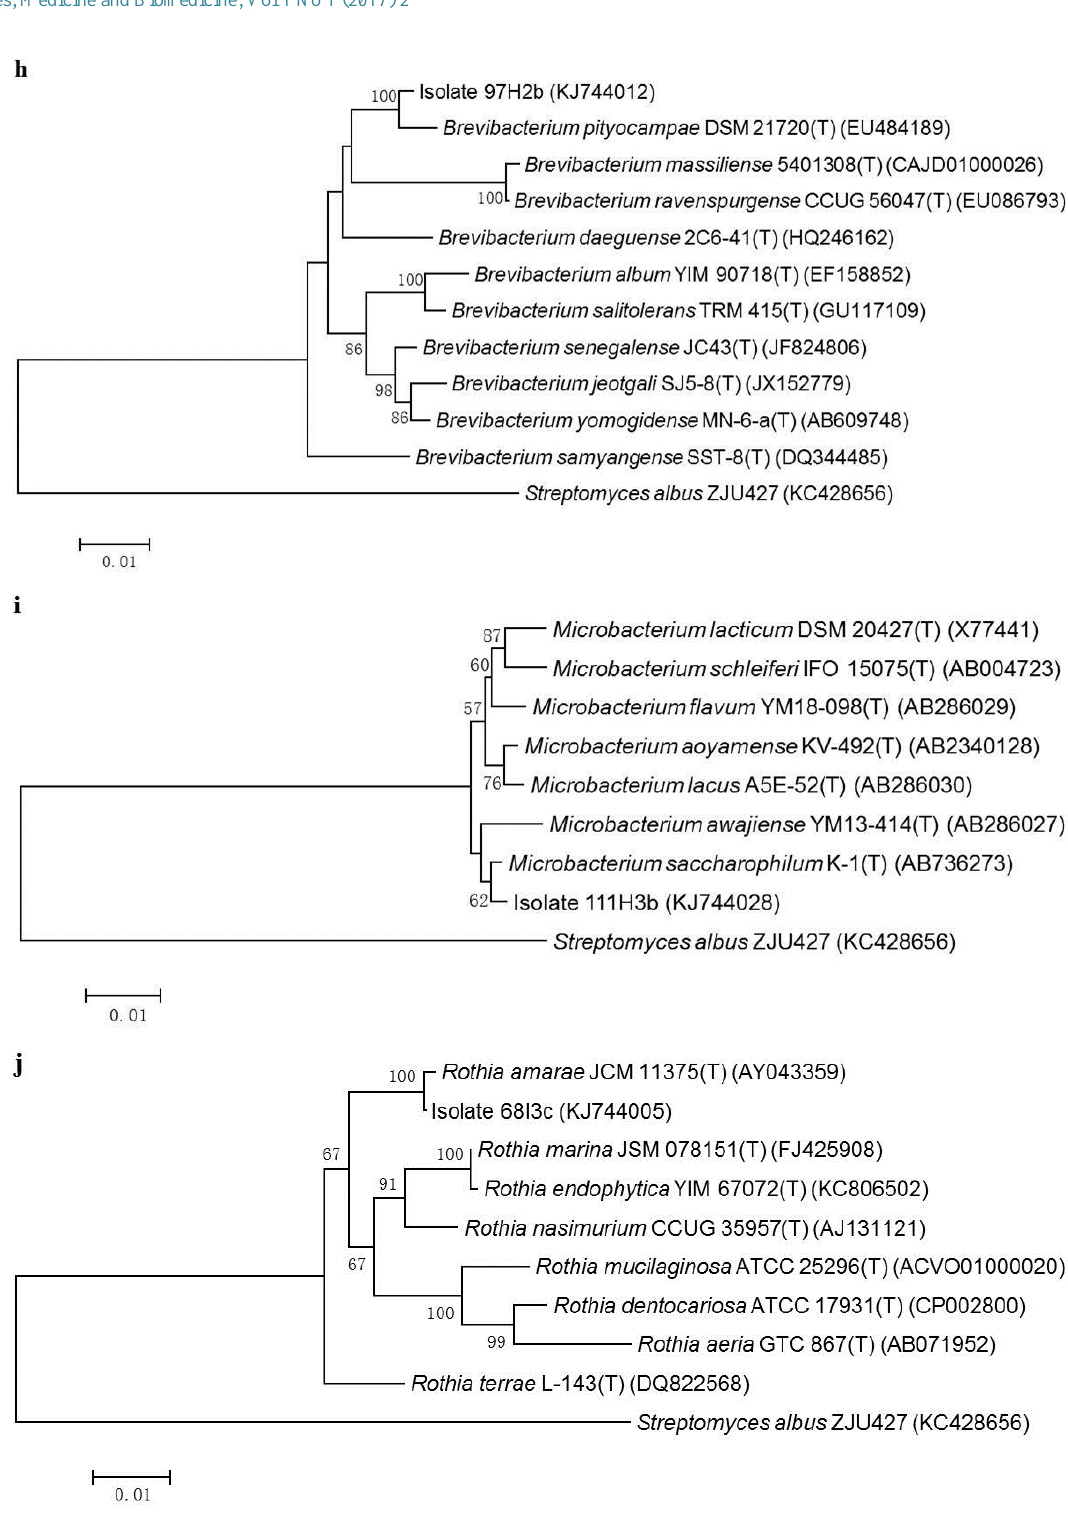
Figure 3: Neighbour-joining tree based on partial 16S rRNA gene sequences showing phylogenetic relationships between culturable rare Actinobacteria isolates and their relative type strains, (a) Streptomyces, ( b) Micrococcus, ( c) Micromonospora, ( d) Rhodococcus, ( e) Kocuria, ( f) Brachybacterium, ( g) Dermacoccus, ( h) Brevibacterium, ( i) Microbacterium and ( j)